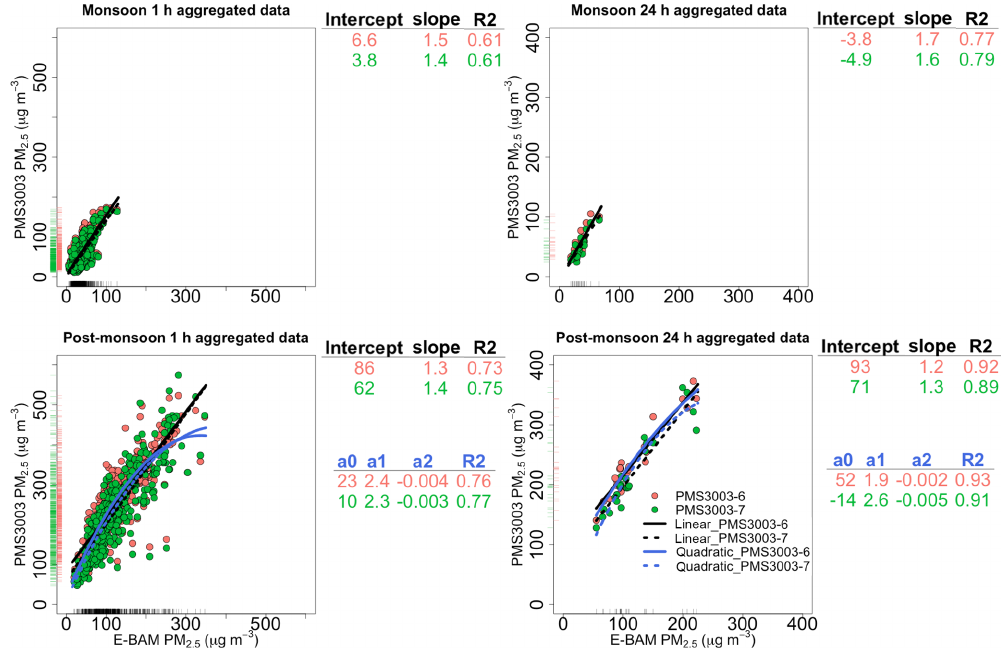
Figure 10. Linear regressions between aggregated PM 2 . 5 mass concentrations (µgm − 3 ) of the E-BAM and the two uncalibrated PMS3003 sensors at 1 and 24h time intervals during the monsoon season (from 8 to 29 June 2017) and the post-monsoon season (from 23 October to 16 November 2017) at IIT Kanpur (6 and 12h results are shown in Fig. S9). The fit coefficients for the calibration models are provided. Marginal rugs were added to better visualize the distribution of data on each